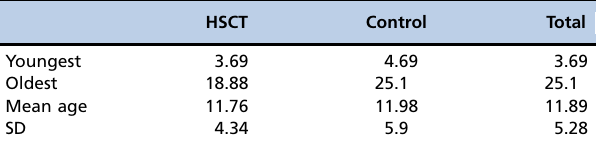
Table 2 - Age (years) distribution of childhood HSCT patients and matched